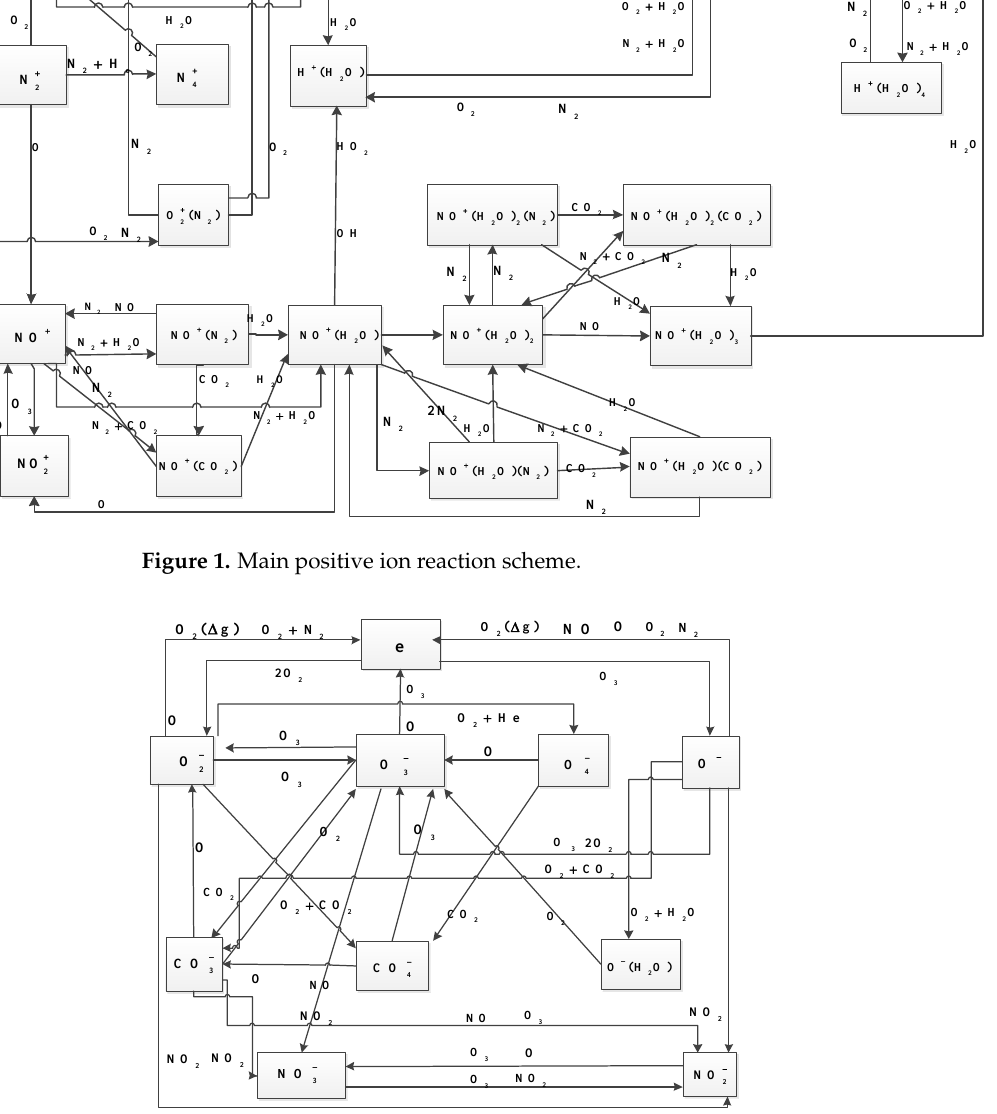
Figure 2. Main negative ion reaction scheme.